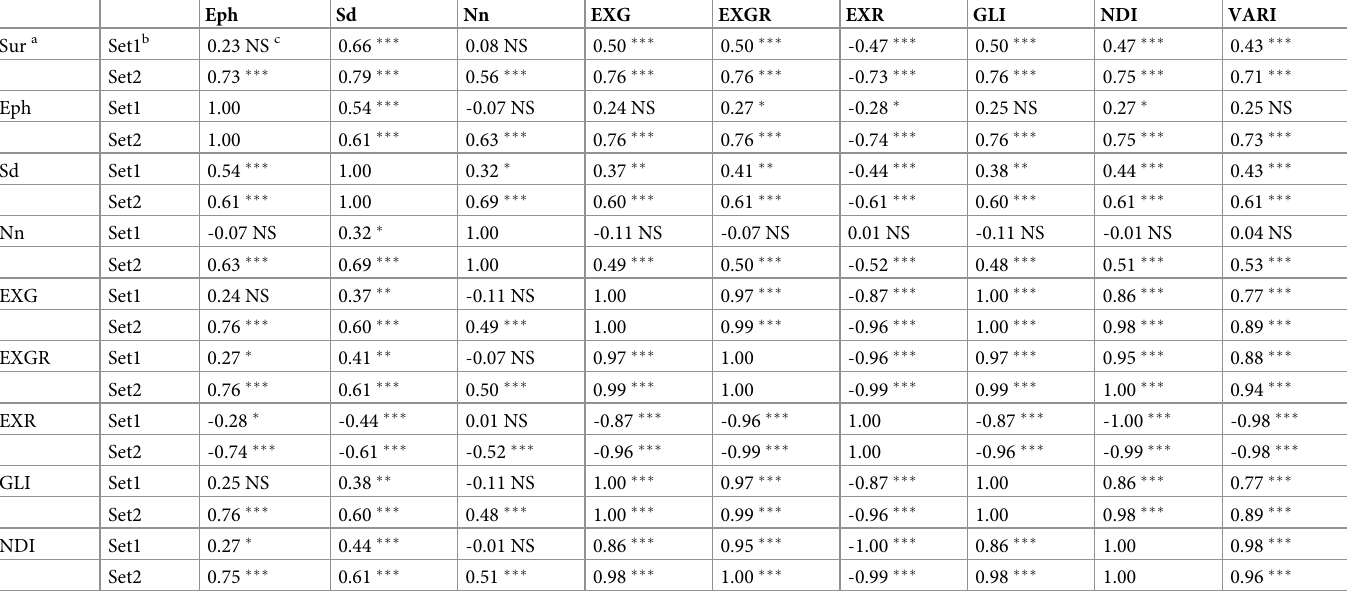
Table 6. Spearman’s rank correlation among surface of an individual plant, estimated plant height, actual plant height, stem diameter, number of nodes, EXG, EXGR, EXR, GLI, NDI, and VARI in kenaf germplasm at two growth stages.